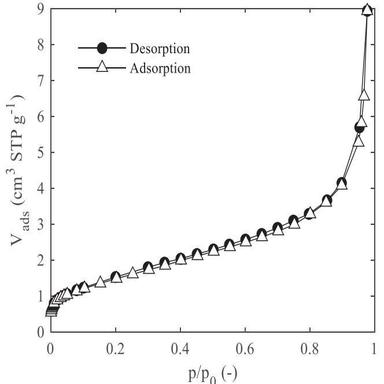
Nitrogen adsorption isotherm at 77 K for the FDM α-alumina substrate sintered at 1200 ◦C.